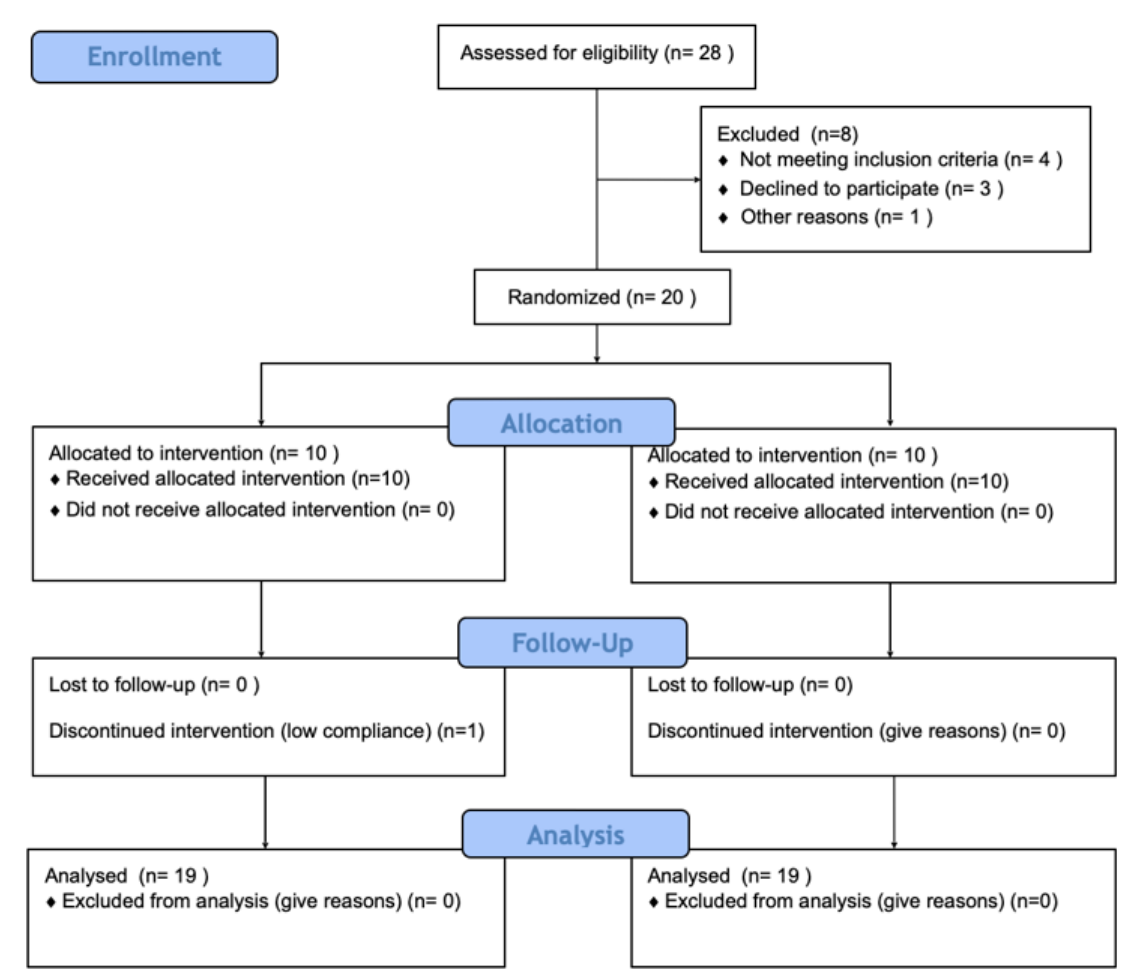
Figure 2. CONSORT statement. Participants allocated to Group A consumed the treatment in a cocoa – control sequence and those in Group B used the opposite order. Twenty participants completed the first phase of the study (single-dose), and nineteen completed the second phase (sustained consumption). Table 2. Descriptive characteristics of the participants at baseline. Mean (SD).